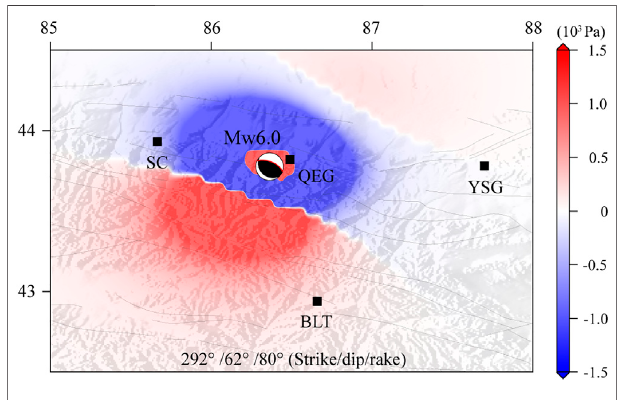
FIGURE 6 | The coseismic maximum principal stress fi eld. Positive values represent tensile stresses, and negative values represent compressive stresses. The red line in the beach ball denotes the fault plane.